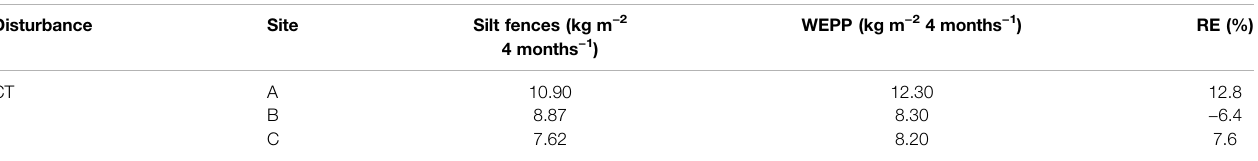
TABLE 3 | Soil erosion estimates for compacted road surfaces predicted by the WEPP model after calibration for the rill erodibility (K r ).